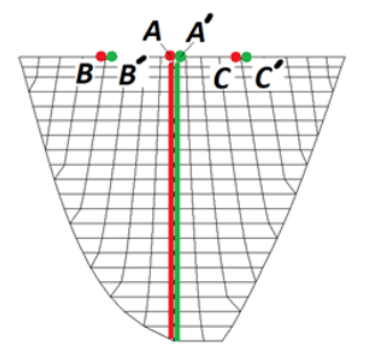
Figure 13. Duplicated nodes in NL-DCM; A and A 0 are central nodes, B and B 0 are left quarter nodes, C and C 0 are right quarter nodes